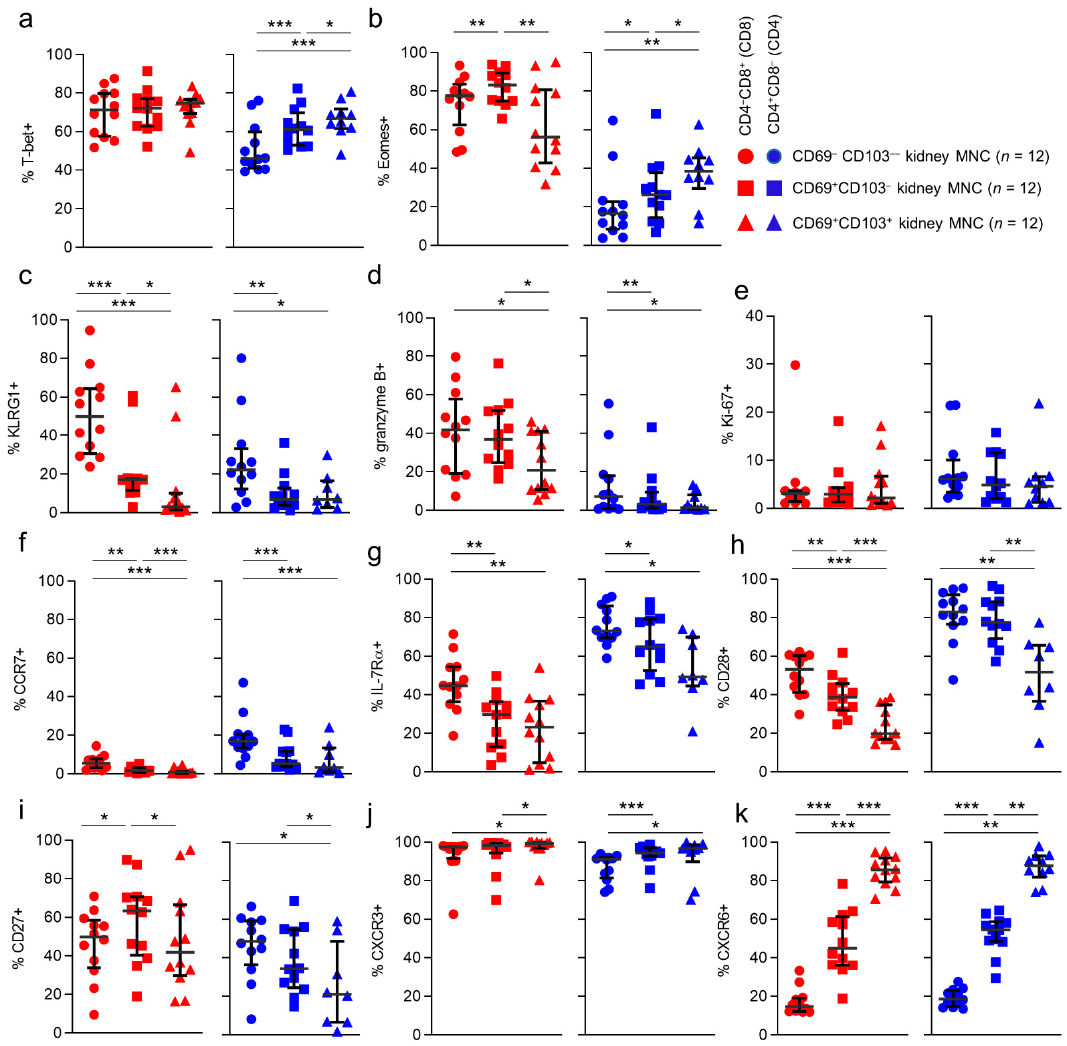
Figure 6. CXCR6 is consistently more often expressed by cells coexpressing CD69 and CD103. ( a – k ) Comparison of expression of T-bet ( a ), Eomes ( b ), KLRG1 ( c ), granzyme b ( d ), ki-67 ( e ), CCR7 ( f ), IL-7R α ( g ), CD28 ( h ), CD27 ( i ), CXCR3 ( j ) and CXCR6 ( k ) in CD69 − CD103 − , CD69 + CD103 − and CD69 + CD103 + subsets within CD8 (red) and CD4 (blue) T cells derived from kidney (median with IQR in black). Wilcoxon signed rank test was used for statistical comparison. Only significant p-values are displayed: * p < 0.05, ** p ≤ 0.01, *** p ≤ 0.001.